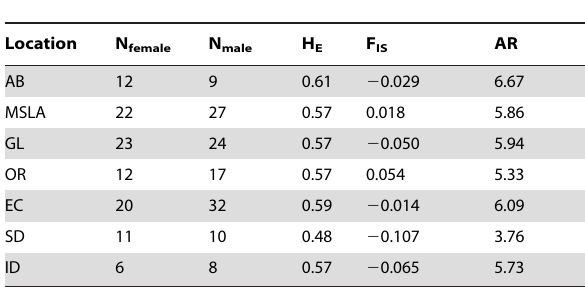
Table 1. The number of individuals included in global spatial autocorrelation analyses and summary statistics of genetic diversity for each